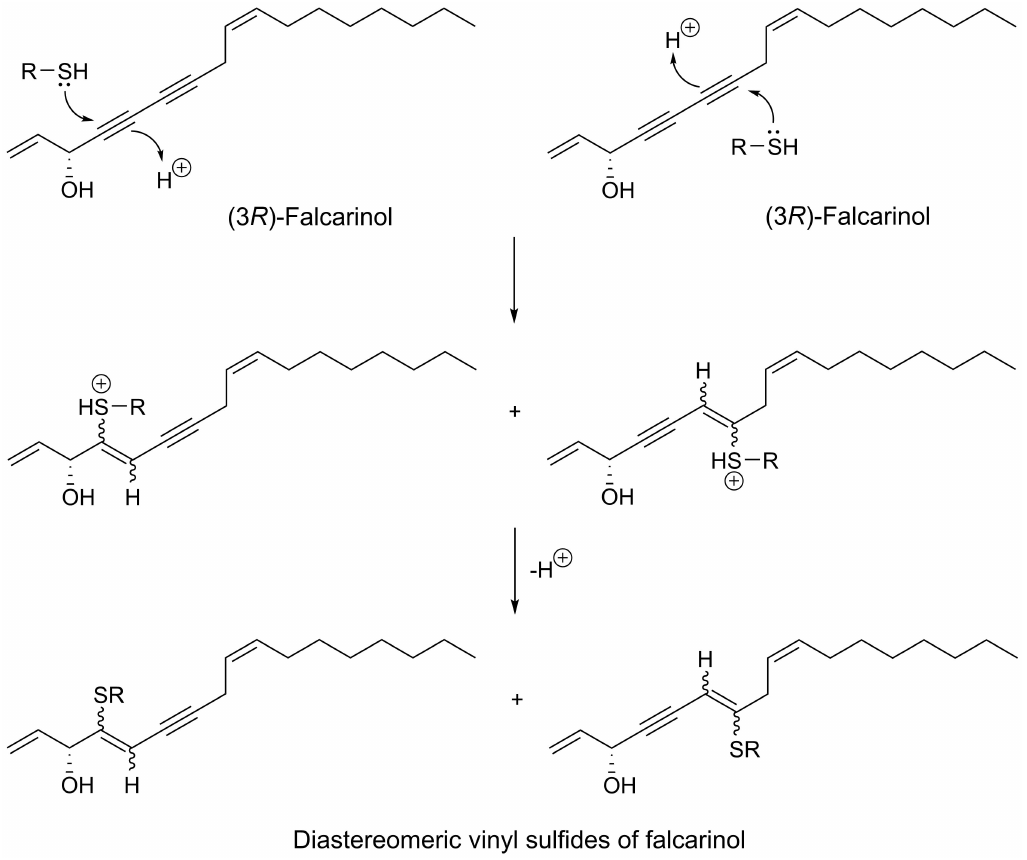
Figure 1. Reaction of (3 R )-falcarinol with thiols in proteins or peptides (R–SH) leading to a mixture of diastereomeric vinyl sulfides of falcarinol. The covalent binding of electrophilic C 17 and C 18 acetylenic oxylipins to nucleophilic biomolecules such as proteins / peptides explains to some extent the cytotoxicity and anti-inflammatory activity of these secondary